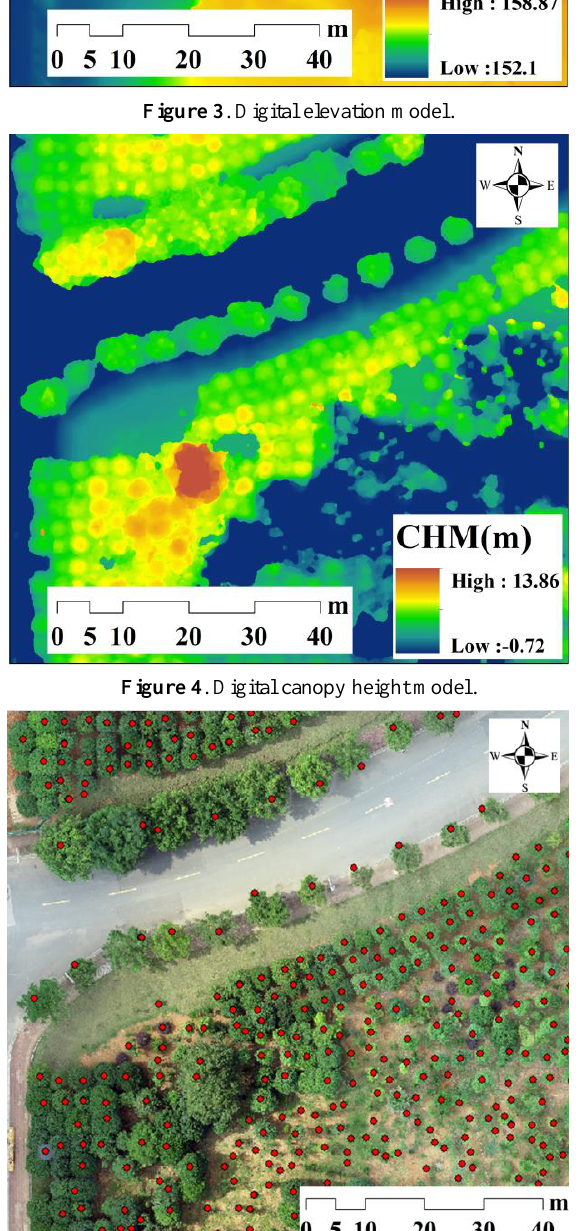
Figure 5 . Extraction results of tree vertices.